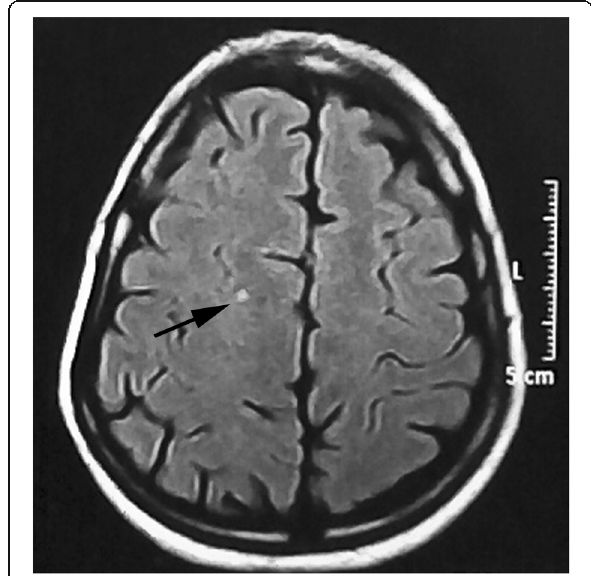
Fig. 1 50-year-old female patient, not known to have any chronic illness, presented with migraine with aura for 10-year duration of grade III severity. Axial FLAIR MRI image shows small single bright focus at the right centrum semiovale (arrow)